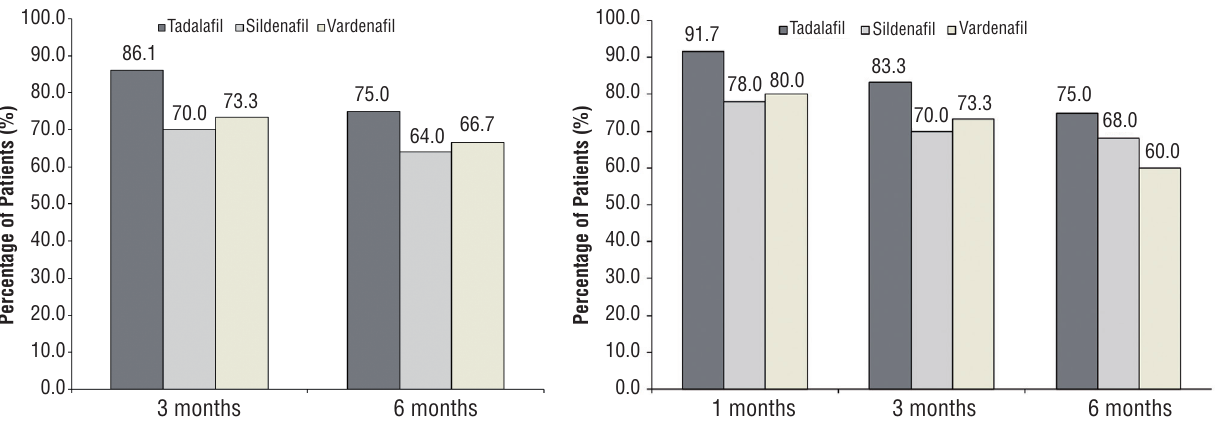
N = overall number of patients in treatment group; n = number of patients who met the criteria for indicated parameter. Note: Additionally, persistent but not adherent patients at 3 months included 2 tadalafil, 3 sildenafil, and 1 vardenafil patient, and at 6 months included 2 tadalafil, 2 sildenafil, and 1 vardenafil patient.